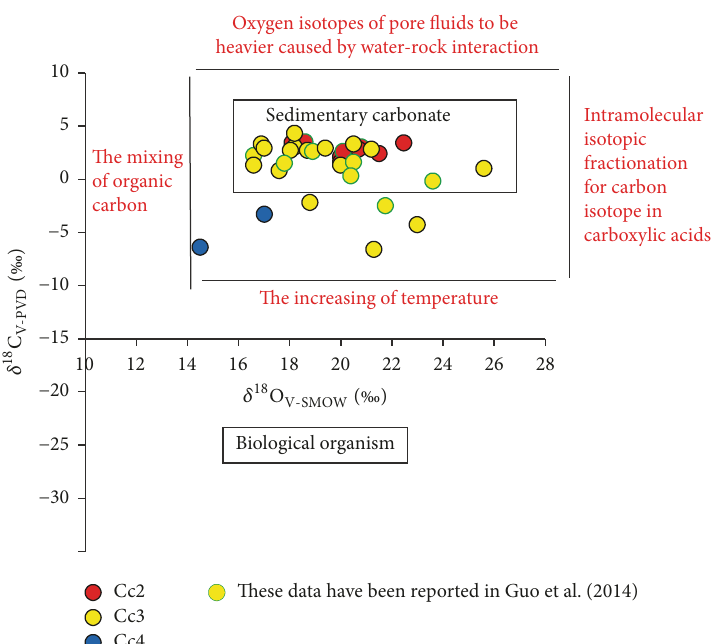
Figure 9: Isotope characteristics of carbonate cements with different morphologies in Es sandstones, Dongying Sag [37–46].